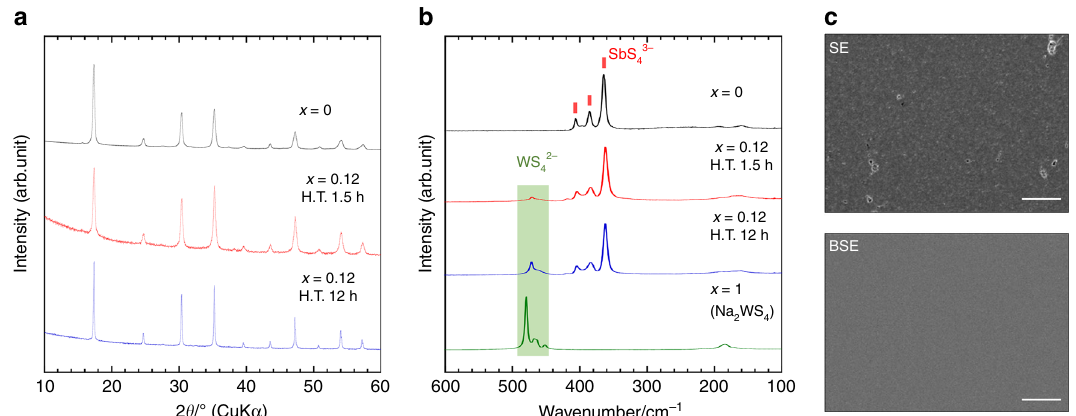
Fig. 1 Structural data for Na 3 − x Sb 1 − x W x S 4 ( x = 0 and 0.12) electrolytes prepared by heat treatment (H.T.) at 275 °C for 1.5 – 12 h. a X-ray diffraction patterns, b Raman spectra, and c cross-sectional SEM images (scale bar: 1 μ m) of the prepared Na 3 − x Sb 1 − x W x S 4